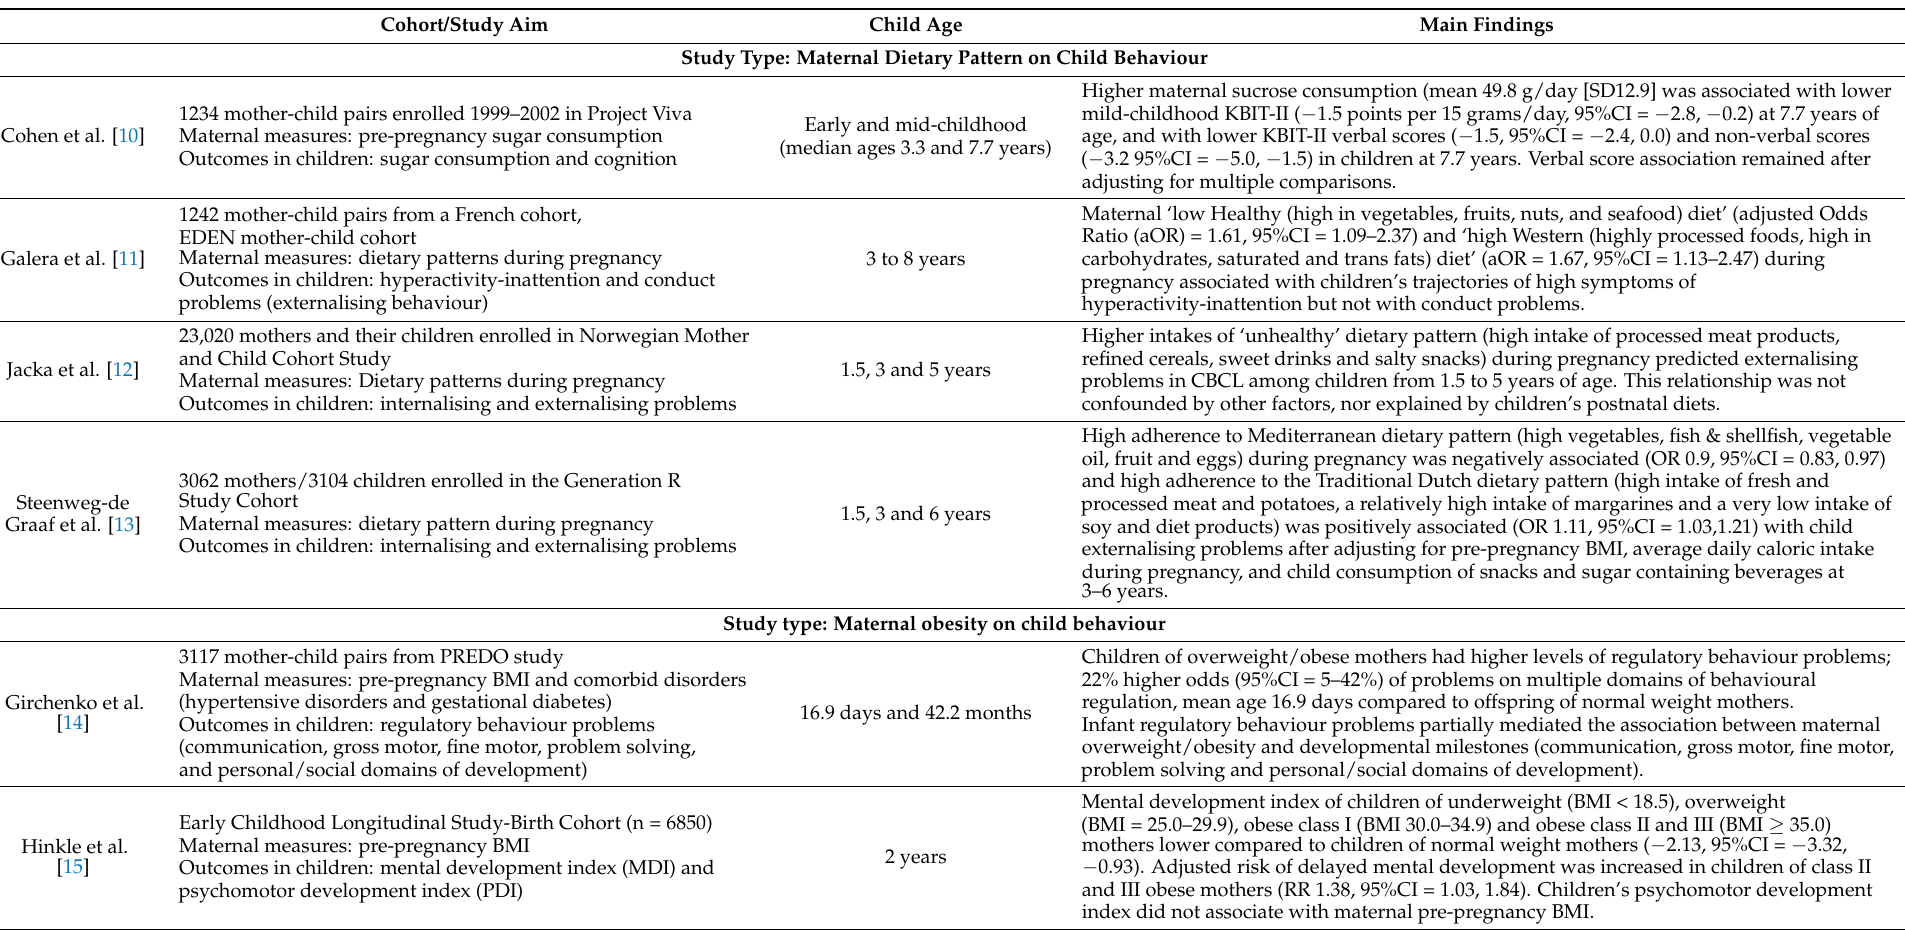
Table 1. Summary of clinical studies examining associations between maternal obesity and diet quality on offspring brain development and behaviour